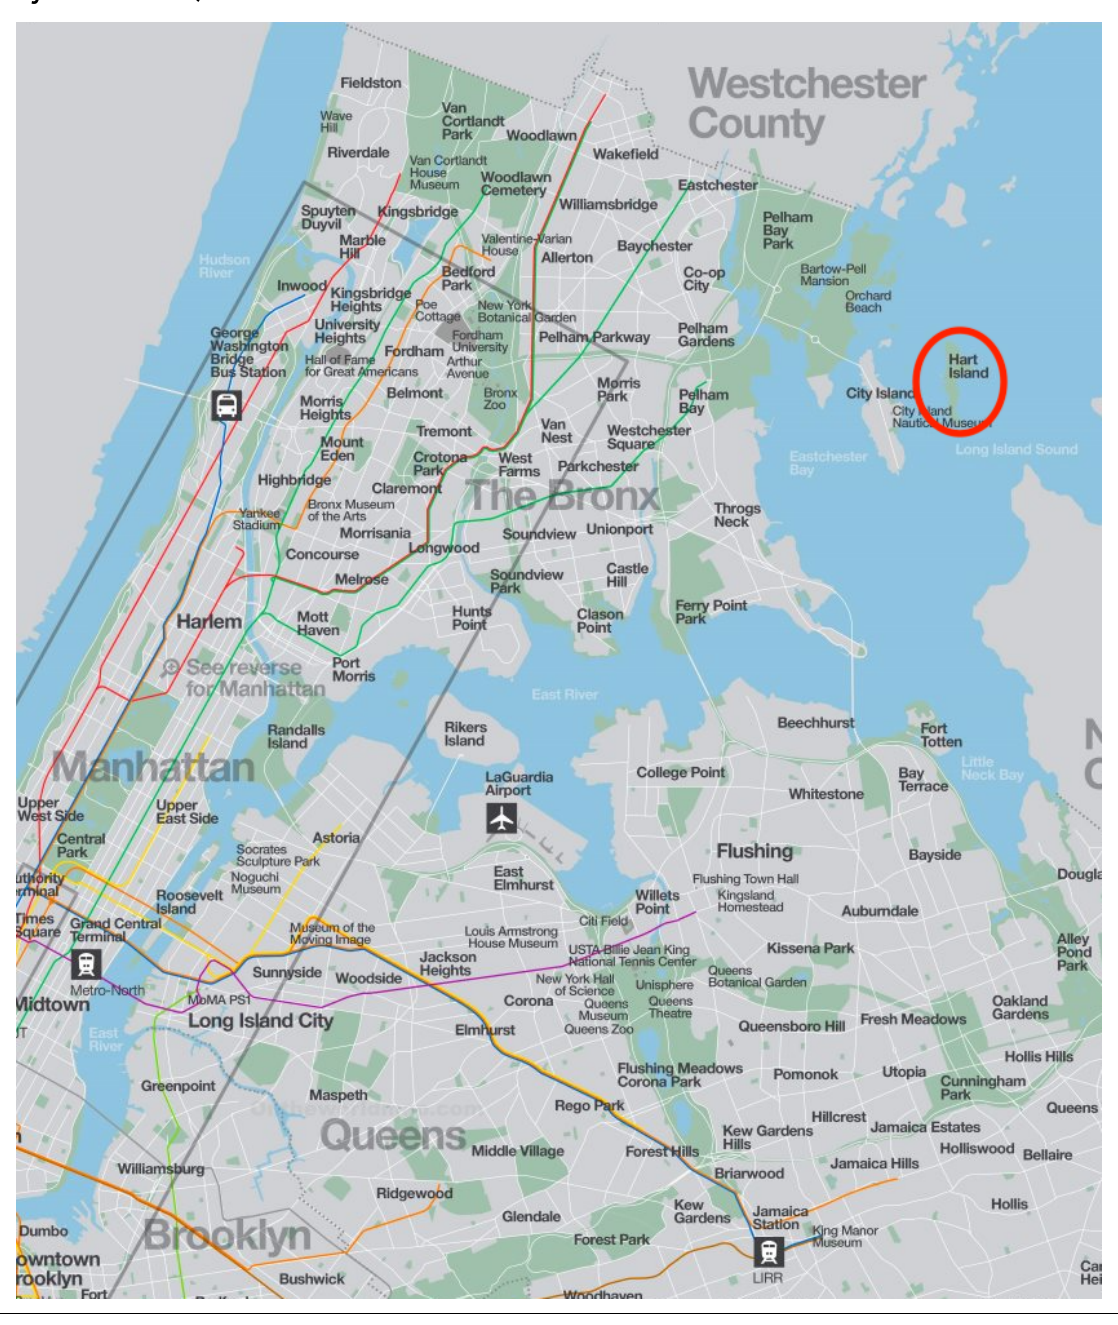
Figure 1. A cropped map from Walk NYC, which does indicate the location of Hart Island (Source: City of New